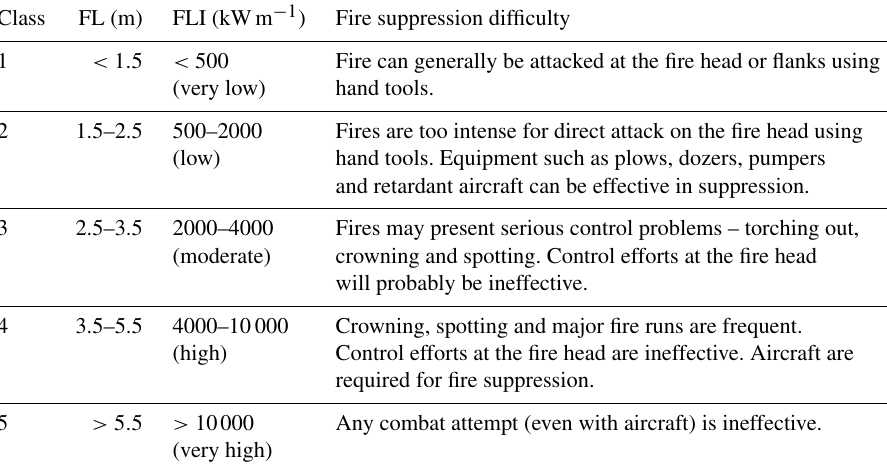
Table D1. Classes of fireline intensity (FLI) and flame length (FL) translated to fire suppression difficulty. Adapted from Alexander and Cruz